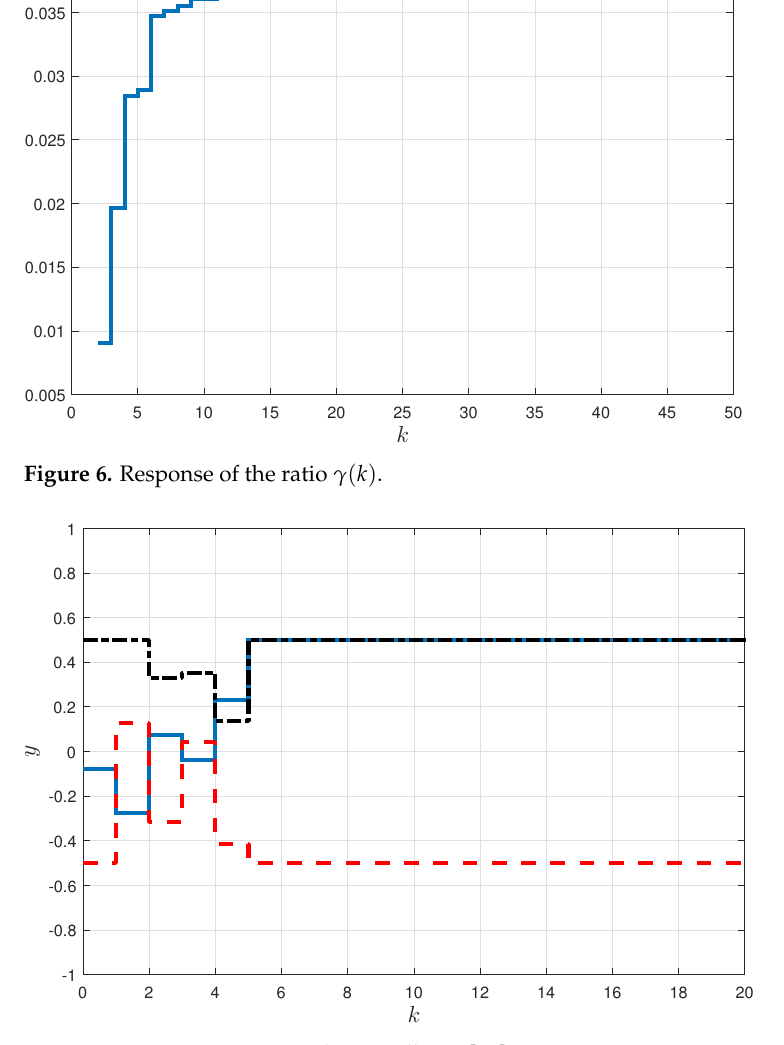
Figure 7. Output response with controller in